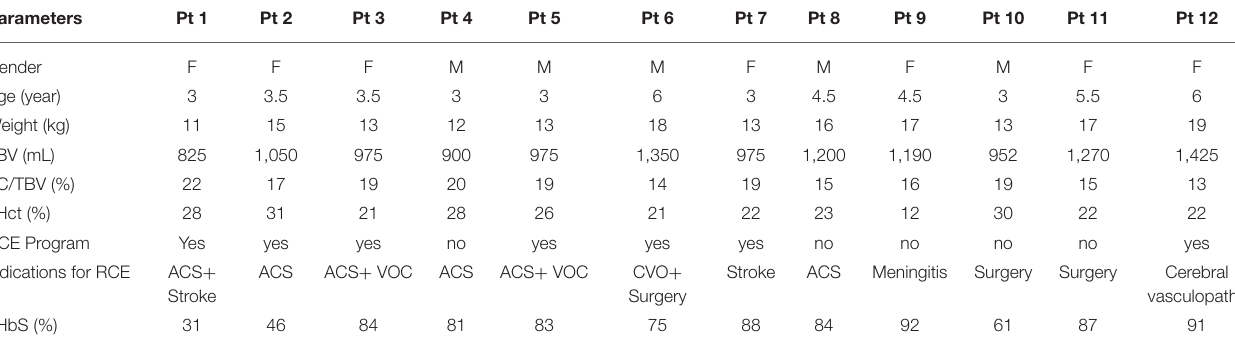
TABLE 1 | Clinical characteristics of the 12 patients with sickle cell anemia (SCA) at the beginning of red blood cell exchange/red blood cell (RCE/RBC)-primed. Parameters Pt 1